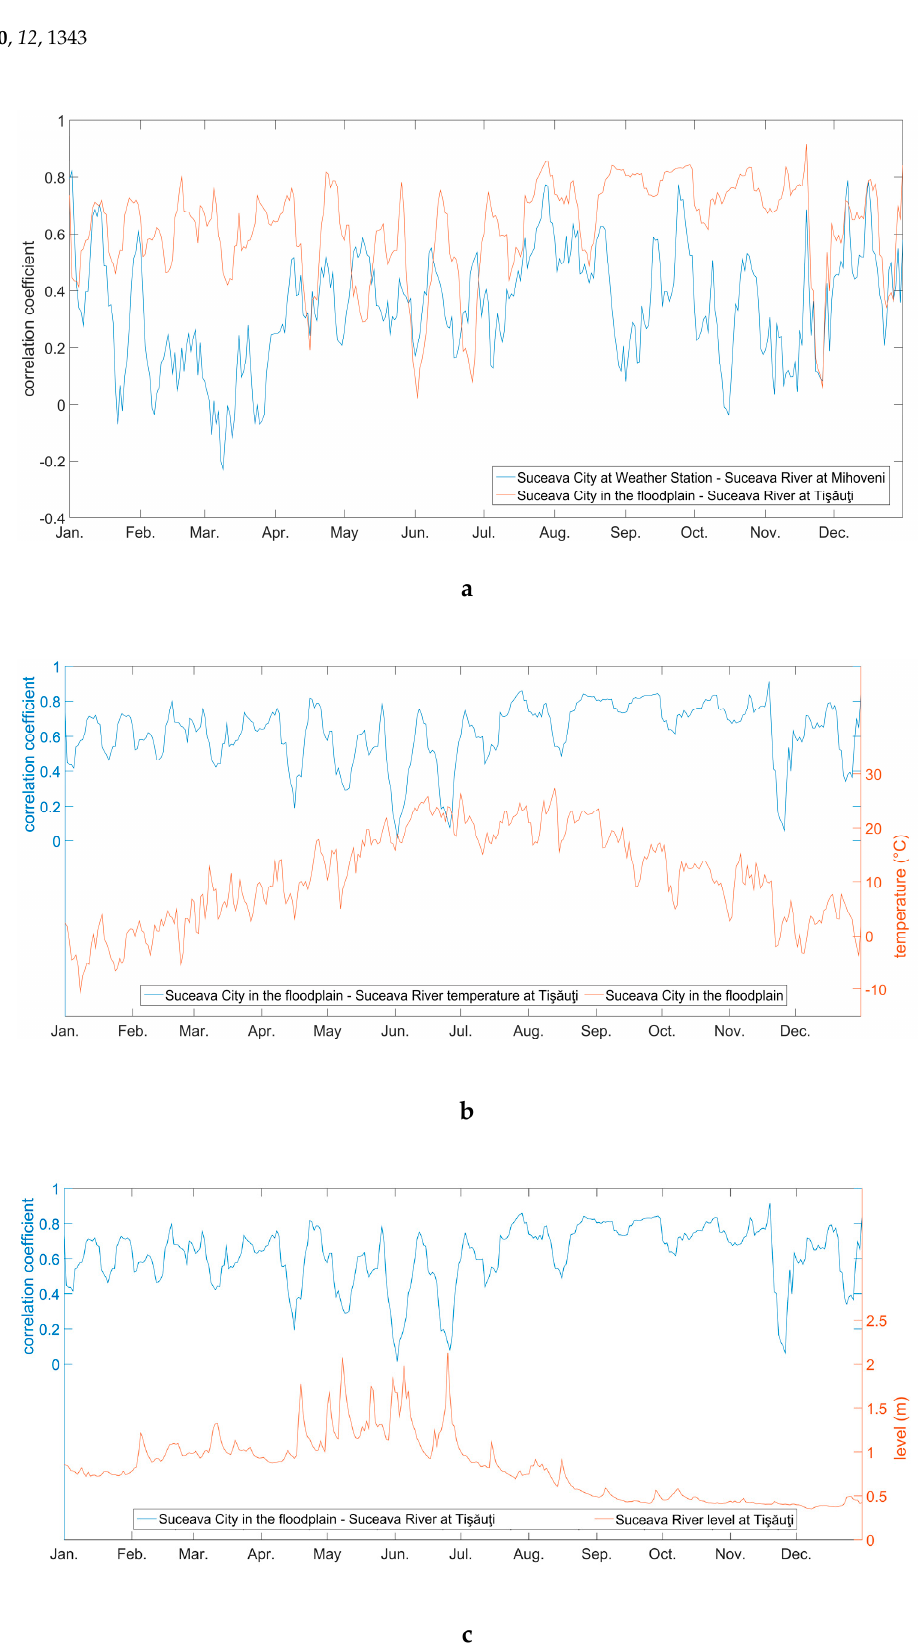
Figure 13. Comparative temporal evolutions of various scaled correlations’ time series (smoothed with a span of 1 week / 7 values) and water / air parameters of Suceava city area in 2019: ( a ) scaled correlations of upstream versus downstream time series, ( b ) downstream scaled correlations versus air temperature in the floodplain, ( c ) downstream scaled correlation versus water level at Ti şă u ţ i.